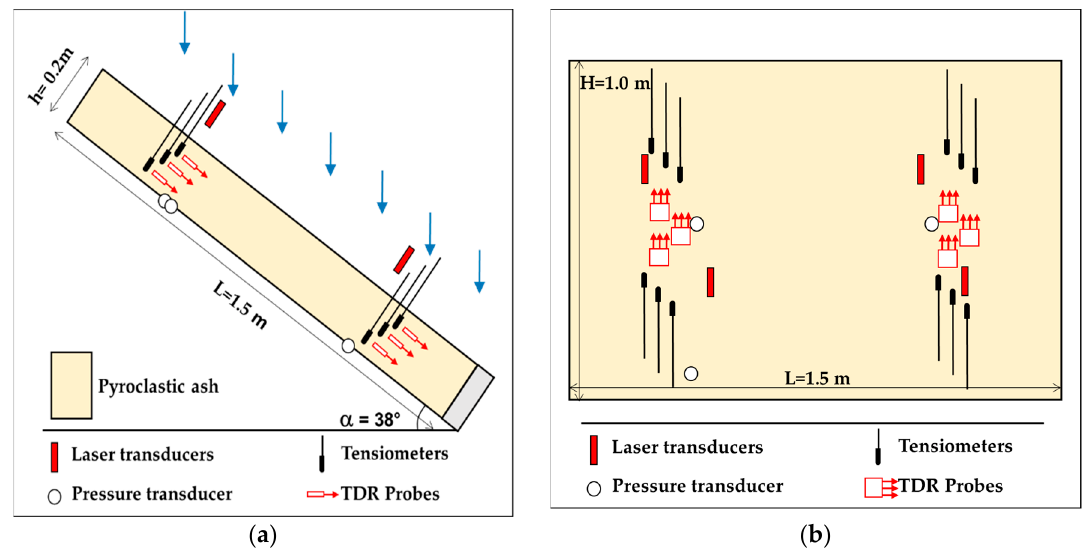
Figure 10. ( a ) Position of the sensors in section; and ( b ) position of the sensors (plan).